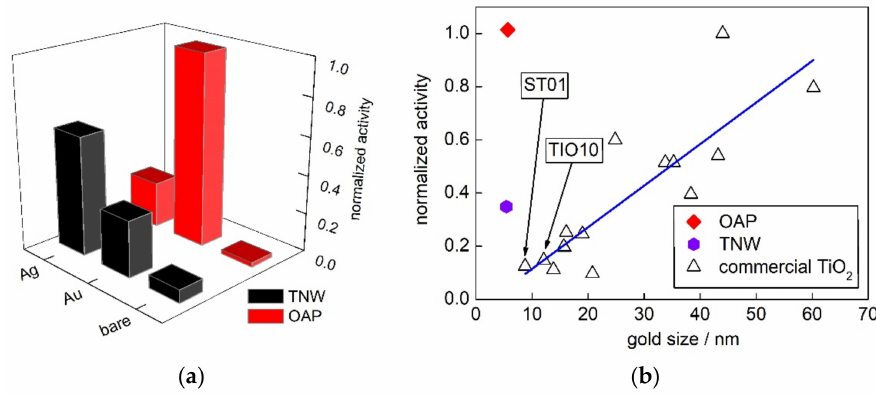
Figure 10. Vis-photocatalytic activity of bare and NM-modified samples: ( a ) Comparison of vis-activity of TNW and OAP samples; and ( b ) correlation between gold crystallite size and photocatalytic activity of Au-modified TNW, OAP and 15 commercial titania